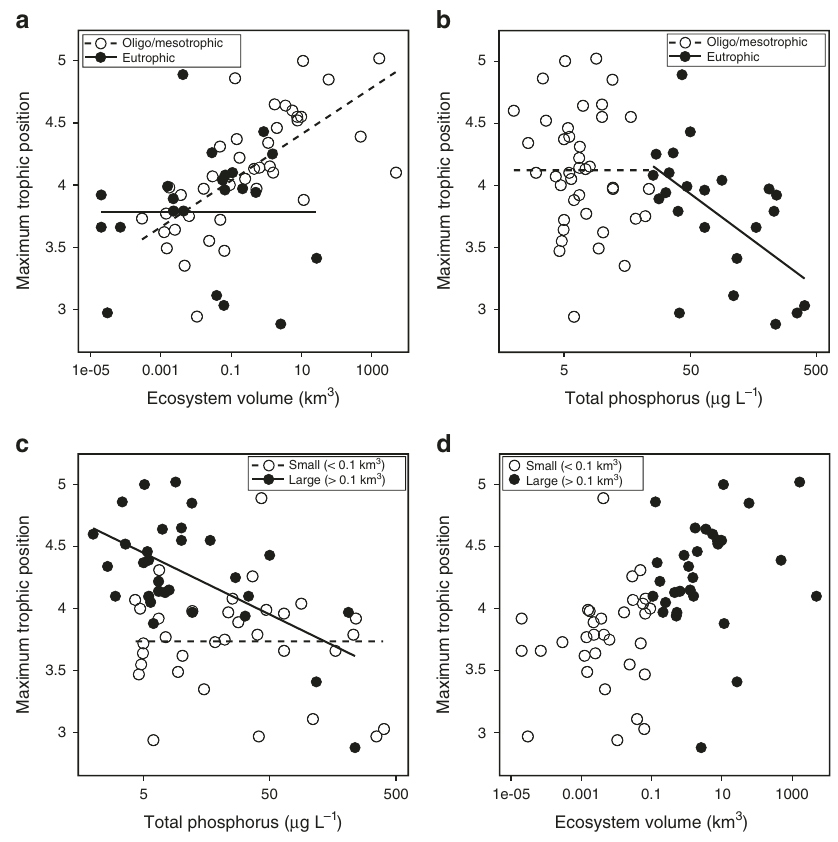
Fig. 5 Evaluating support for context-dependent effects of ecosystem size and productivity on FCL (predictions in Fig. 2c, e) in lake ecosystems. a Food chain length is related to ecosystem volume in oligo- and mesotrophic lakes (dashed line), but not in eutrophic lakes (solid line shown for demonstrative purposes). b Food chain length is related to total phosphorus in eutrophic (solid line) but not oligo- and mesotrophic lakes (dashed line shown for demonstrative purposes). c Food chain length is related to total phosphorus in large (solid line) but not small lakes (dashed line shown for demonstrative purposes). d Food chain length is not related to ecosystem volume in either small or large